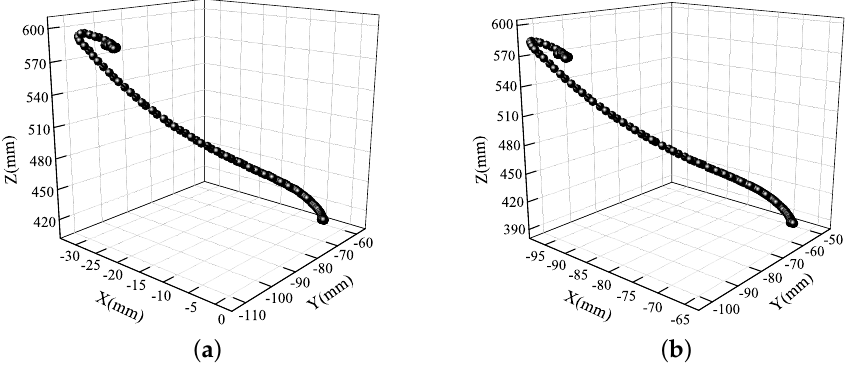
Figure 18. 3D eye trajectories during car acceleration: ( a ) left eye; ( b ) right